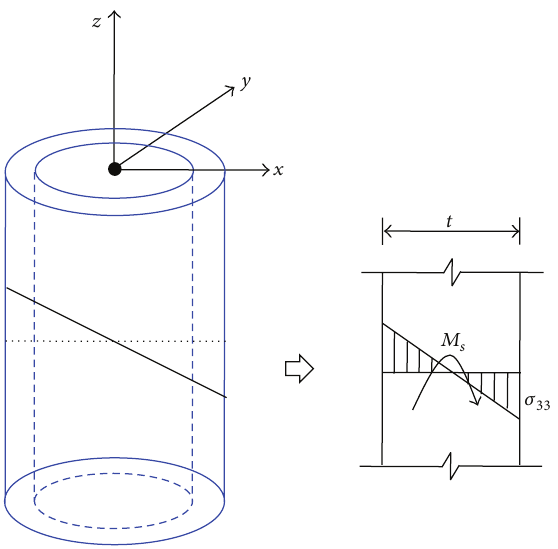
Figure 3: Bending moment of shell